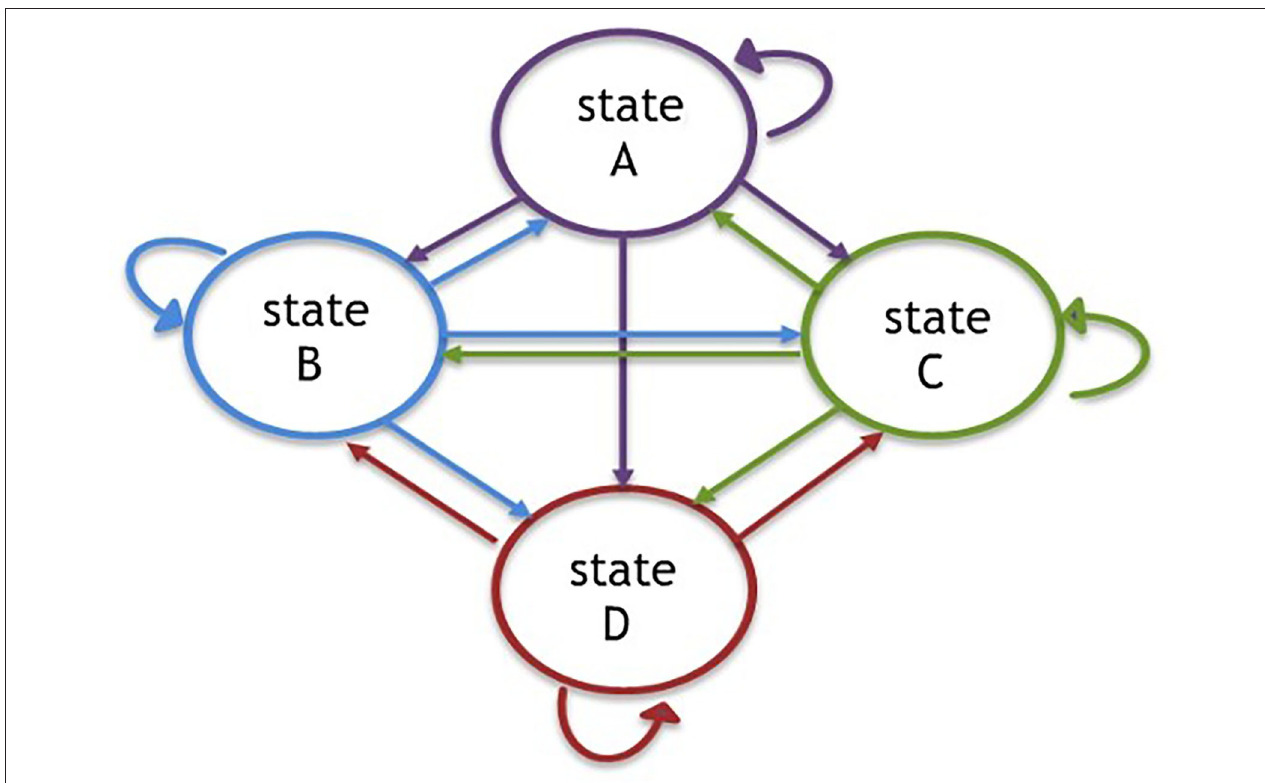
FIGURE 1 | Four states of Markov